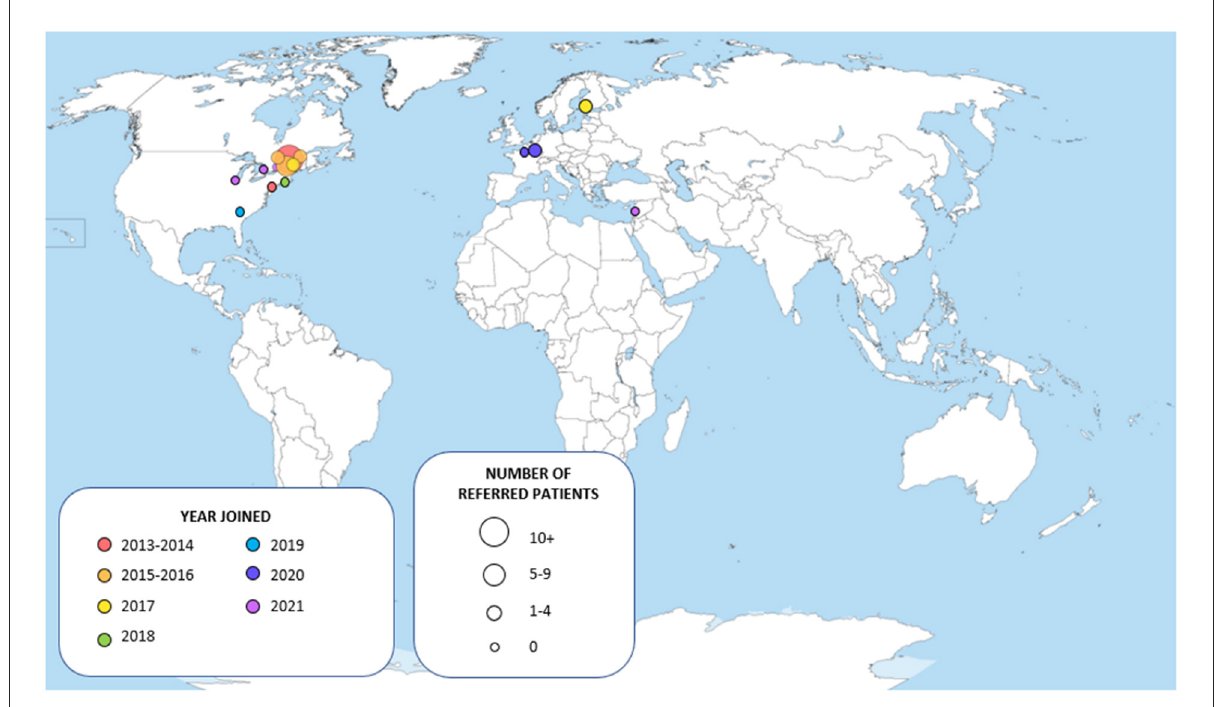
FIGURE1 Map of the centers participating to the White Matter